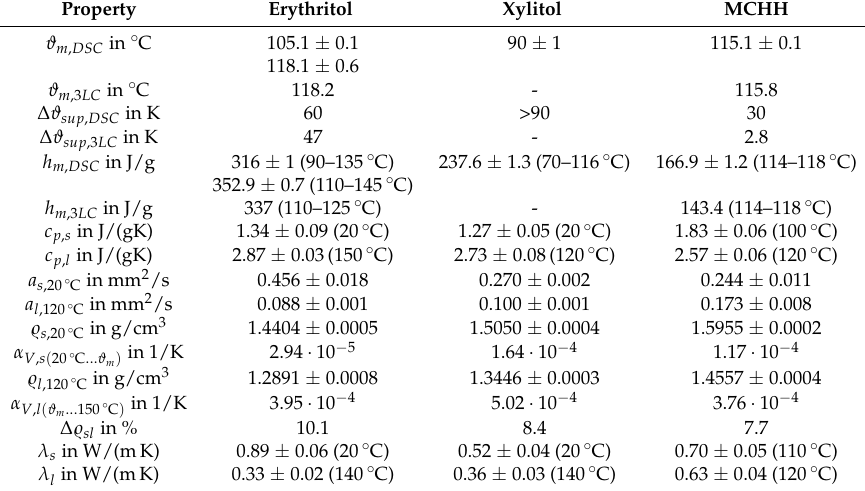
Table 4. Results of the three investigated PCMs including the standard deviation of the measurements. The results for the thermal conductivity are calculated from the measured thermal diffusivities a , densities (cid:36) and heat capacities c p and the deviation is the combined uncertainty of the applied measurement devices.